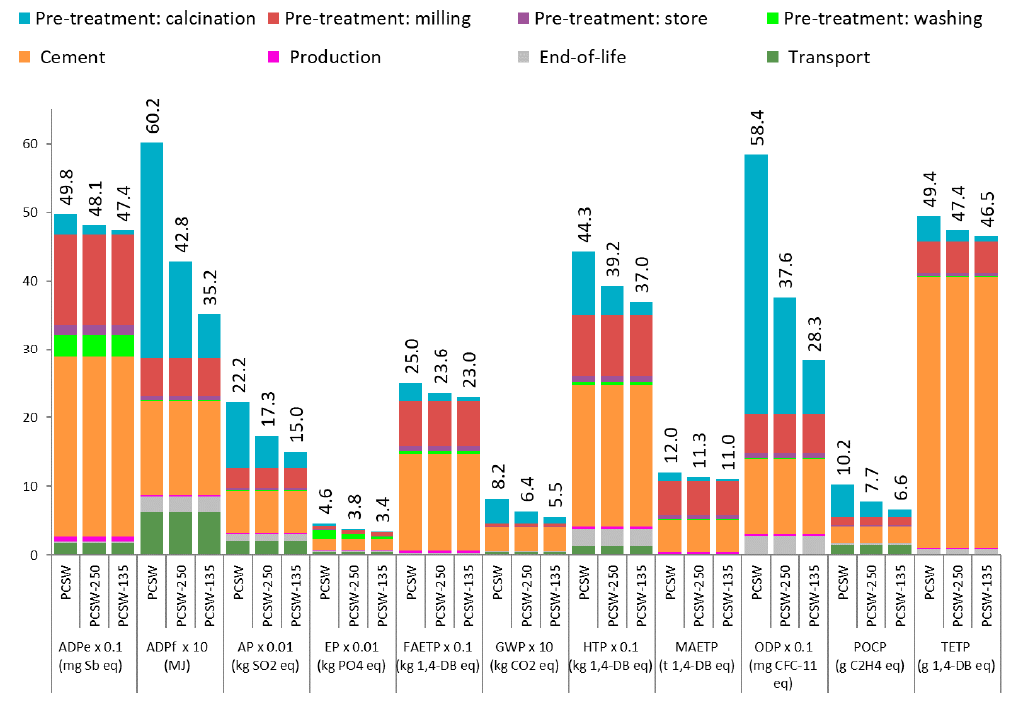
Figure 3. Environmental influence of different calcination temperatures in the pre-treatment of seashell waste. Some impacts should be multiplied by the factor shown to obtain the original values. PCSW-250: porous concrete with seashell waste heated at 250 °C, PCSW-135: porous concrete with seashell waste heated at 135 °C. For the rest of the nomenclatures, consult Figure 2.